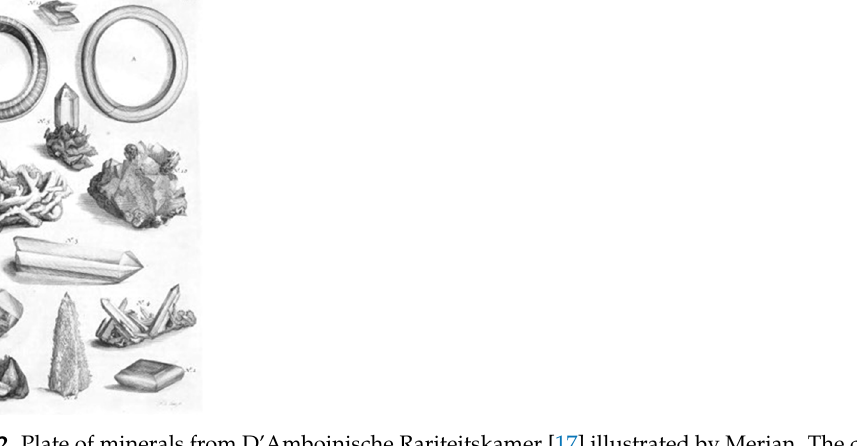
Figure 2. Plate of minerals from D’Amboinische Rariteitskamer [17] illustrated by Merian. The colors of this plate are reproduced by Schuh, but poorly in the pdf file ref.